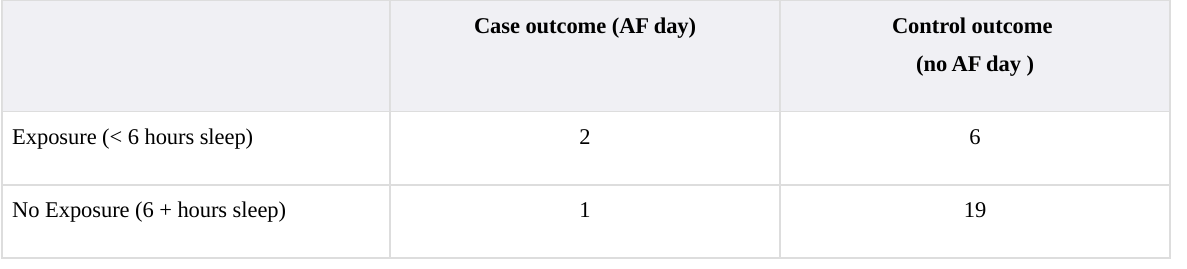
Table 4. Case crossover study